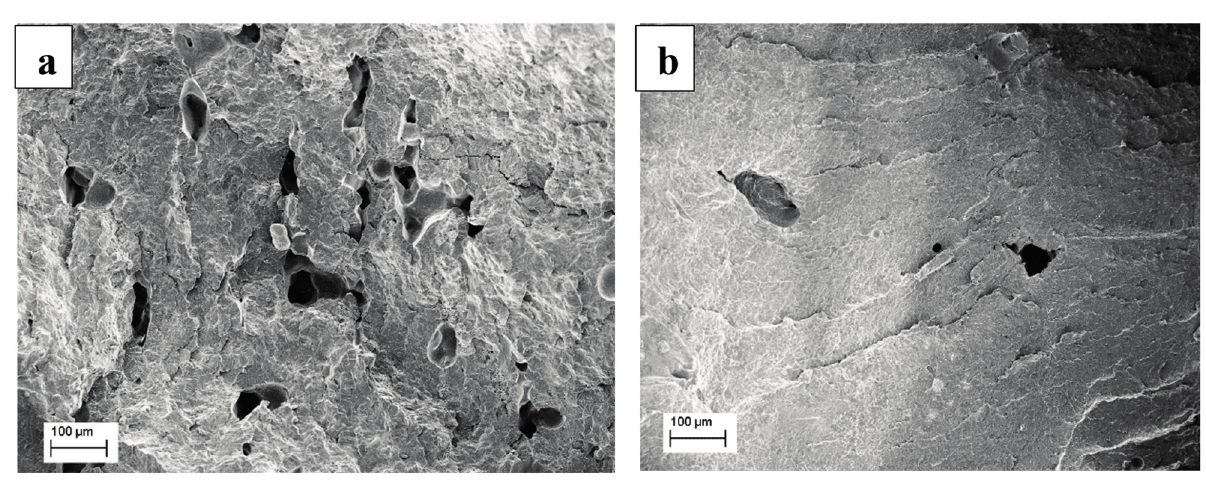
Figure 5. Fracture surface of ( a ) PA12 and ( b ) PA12-CNT